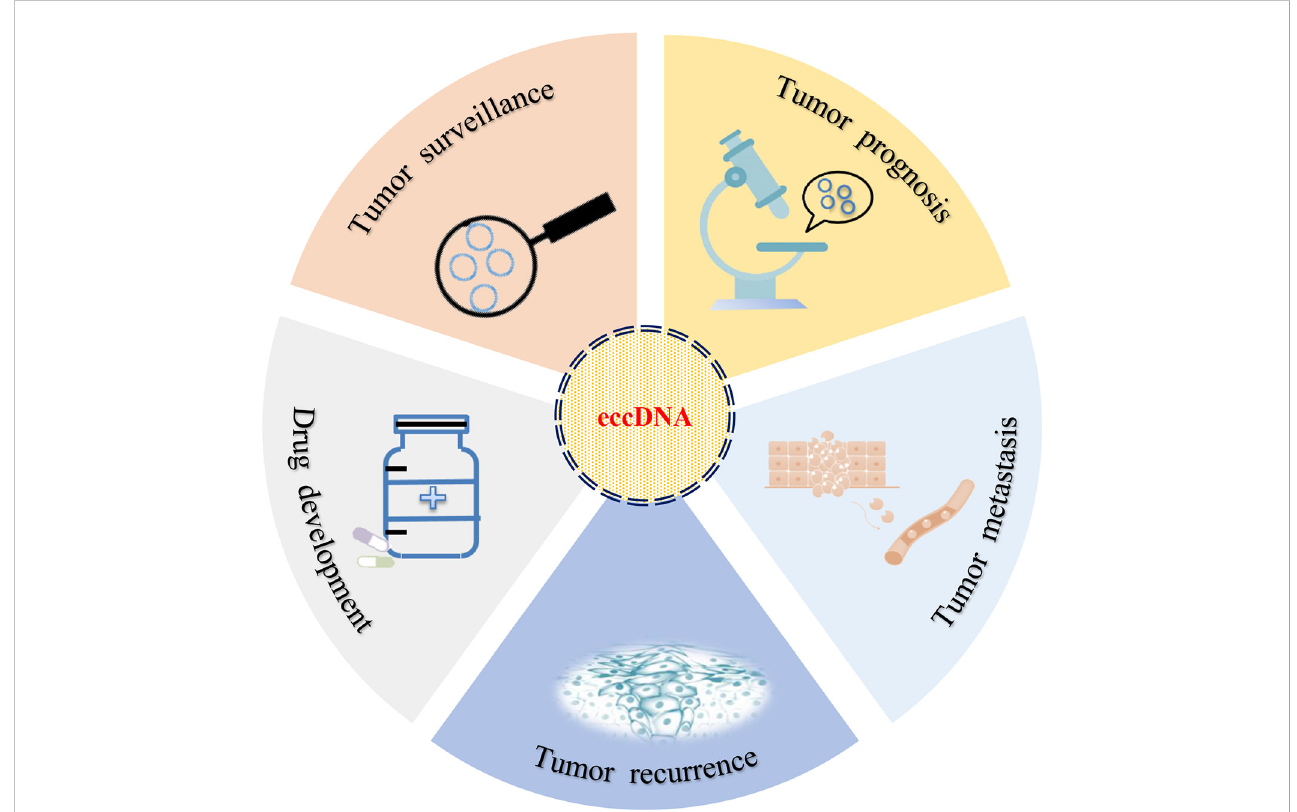
FIGURE 3 Clinical implications of eccDNA. eccDNA may be used as a biomarker for tumor surveillance, prognosis, metastasis, and recurrence. In addition, the development of target drugs may also provide a new strategy for the treatment of cancer in clinical